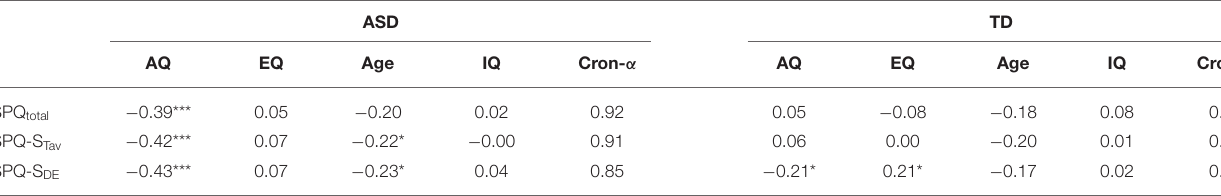
TABLE 3 | Convergent validities and reliabilities of the different SPQ